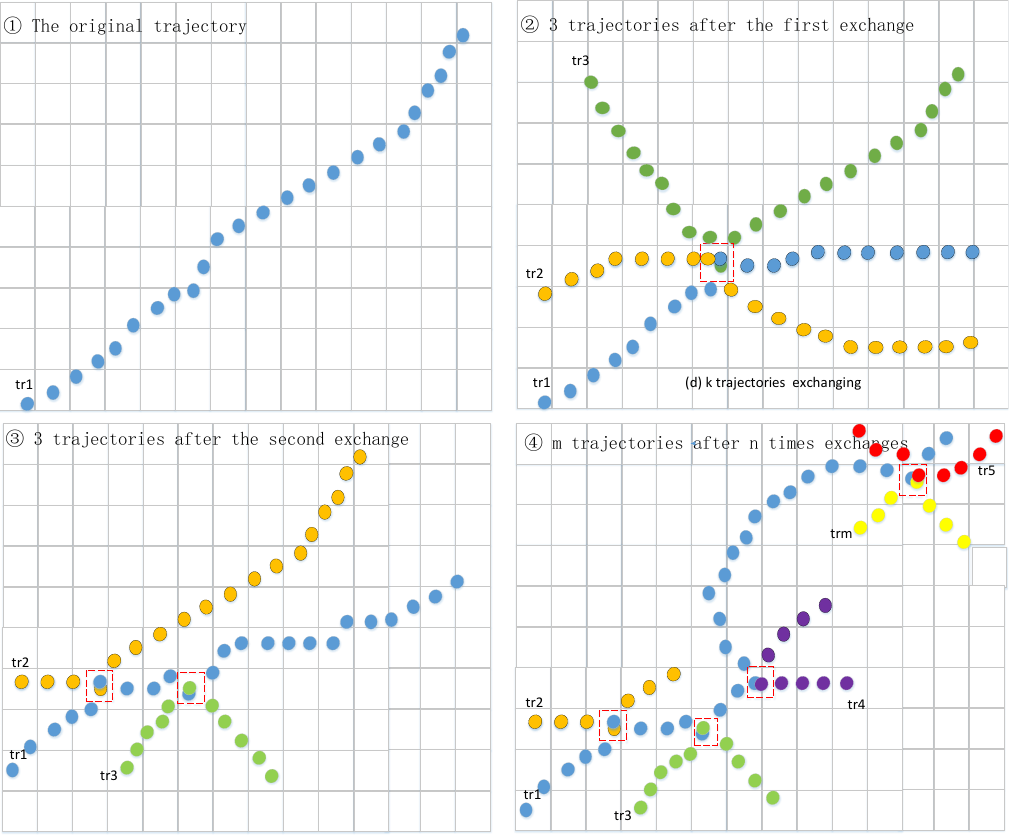
Figure 4. m trajectories after n times